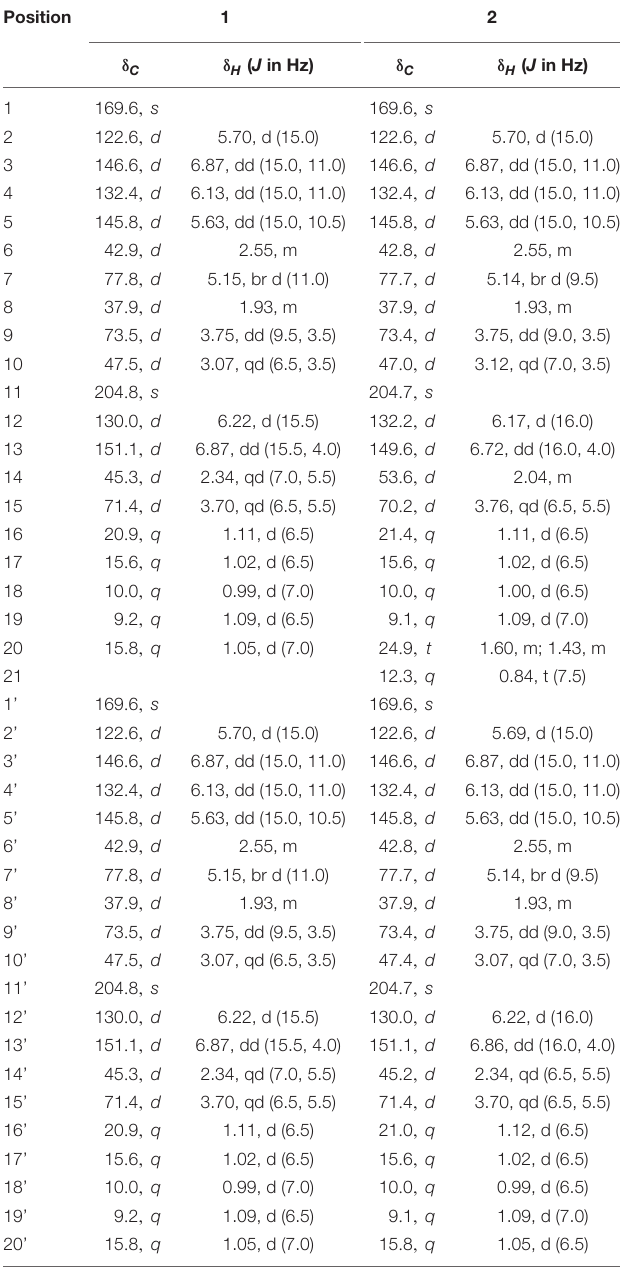
TABLE 1 | 1 H (600 MHz) and 13 C NMR (150 HMz) data of efomycin K ( 1 ) and M ( 2 ) in CD 3 OD. a